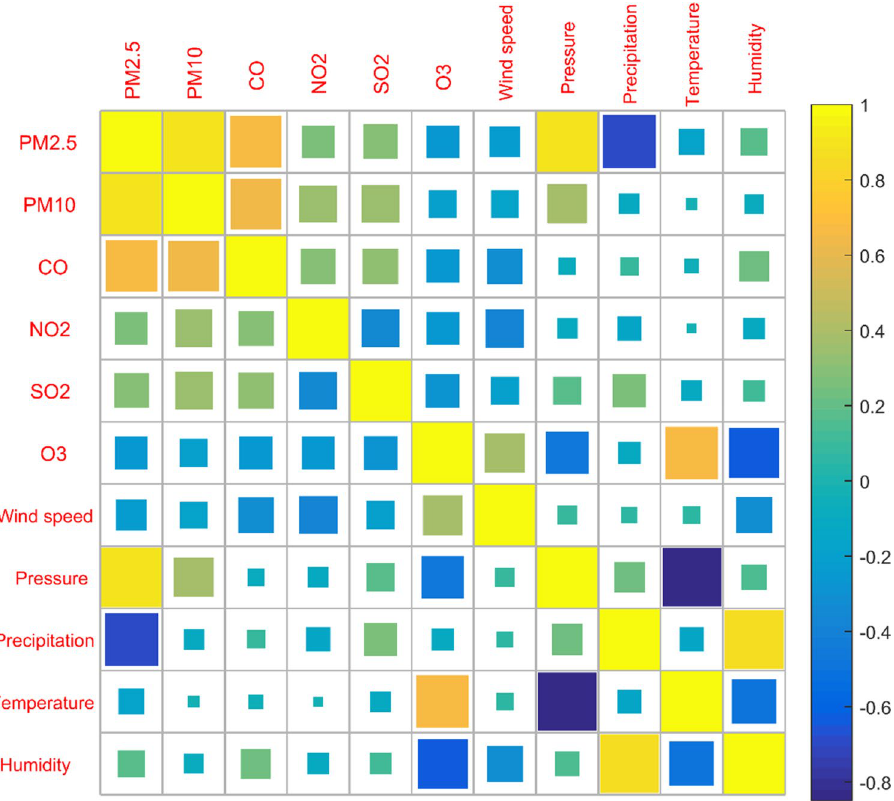
Figure 3. Correlation coefficient matrix color block diagram between six types of air pollutant concentrations and climate.